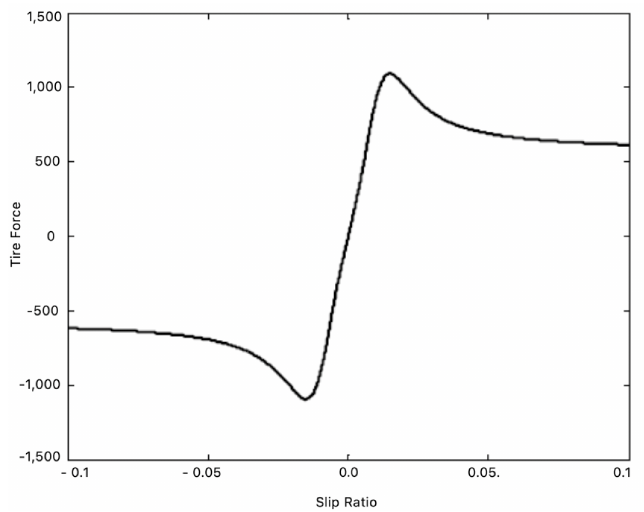
Figure 18. Tire Pressure Curve Calculator (with Magical Formula- Pacejka equation).